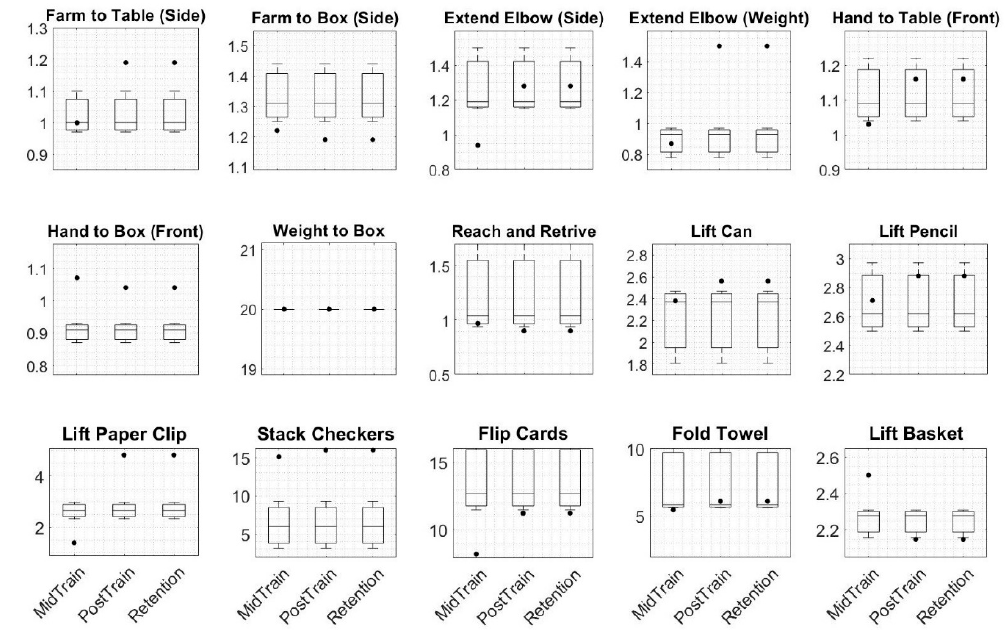
Figure 8. The boxplots for the Wolf motor function test (WMFT) are shown. The three baselines are plotted as boxplots in subplots. The scores for mid training, post training, and retention (one month after six weeks of training) are shown as black-filled dots and are respectively named MidTrain, PostTrain, and Retention. The y axis does not have any unit. The total scores of the four assessments were 65, 65, 74, and 66, respectively. Abbreviations: Farm, forearm.